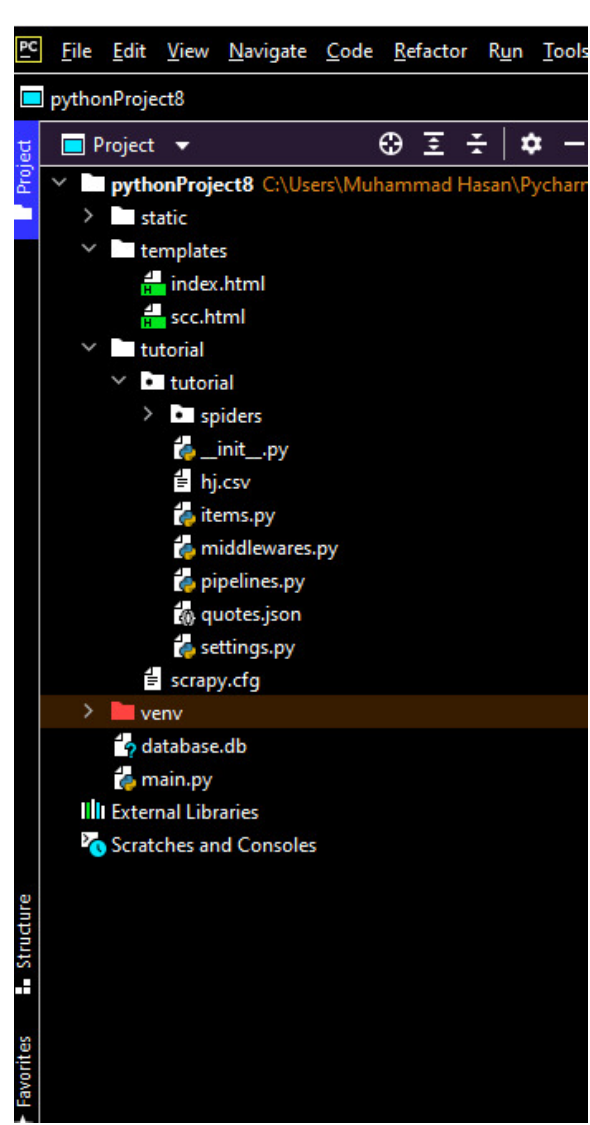
Fig. 4. Hierarchy and connection of